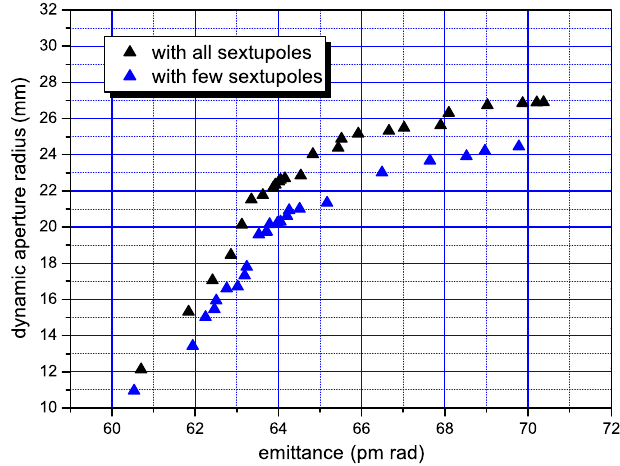
.FIG. 4. The Pareto optimal front of the last generation. The horizontal axis is one of the objectives: emittance, and the vertical axis is the radius indicating dynamic aperture quantity: þ R DA ¼ 2 : 5 (cid:4) R . The black dots are the optimal front min avg with all of the sextupoles on, and the blue dots are the optimal front where two families of combined sextupoles are